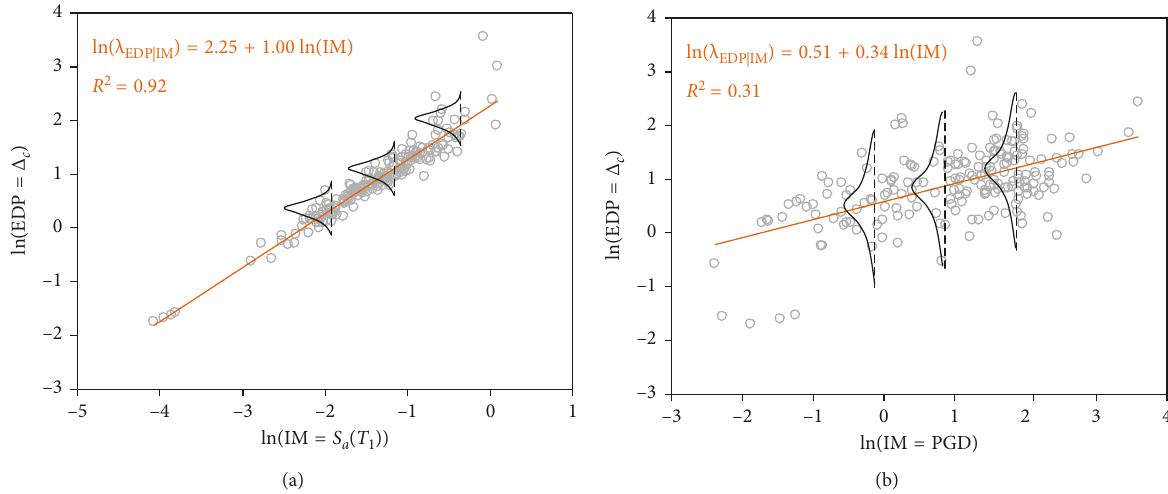
� S c ) from cloud data: (a) IM a ( T 1 ) and